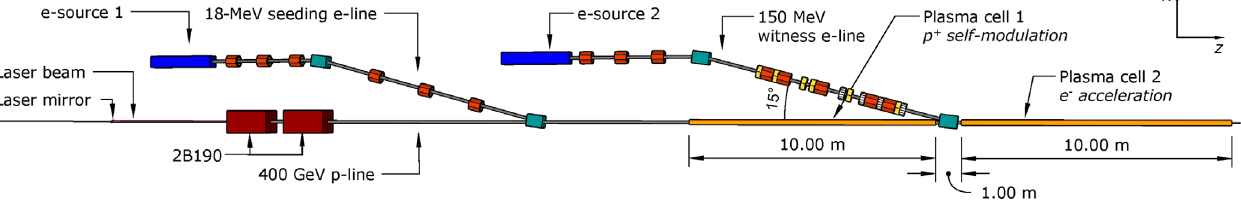
FIG. 1. Schematic of the configuration of the two-electron beamlines, plasma cells, and a section of the proton transfer line. Dipoles are shown in cyan, the quadrupoles in red, the sextupoles in yellow, and the octupoles in white.